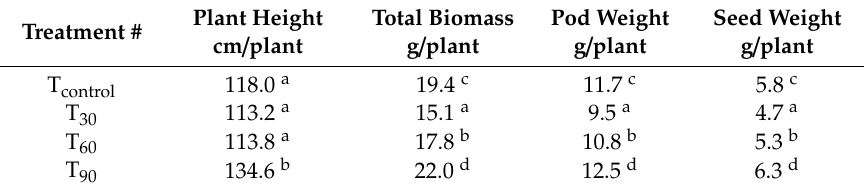
Table 4. Statistical analysis of the canola growth and yield parameters. Plant Height Total Biomass Pod Weight Seed Treatment # cm / plant g / plant g / plant